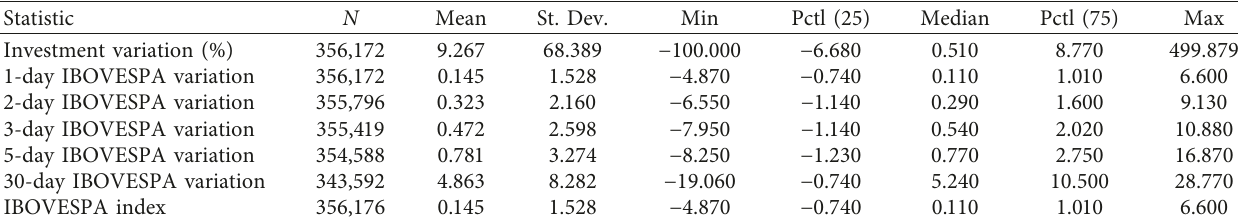
Table 1: Summary statistics of our panel data on investors’ daily trading decisions over the period of 2016 to 2018. Statistic N Mean St.